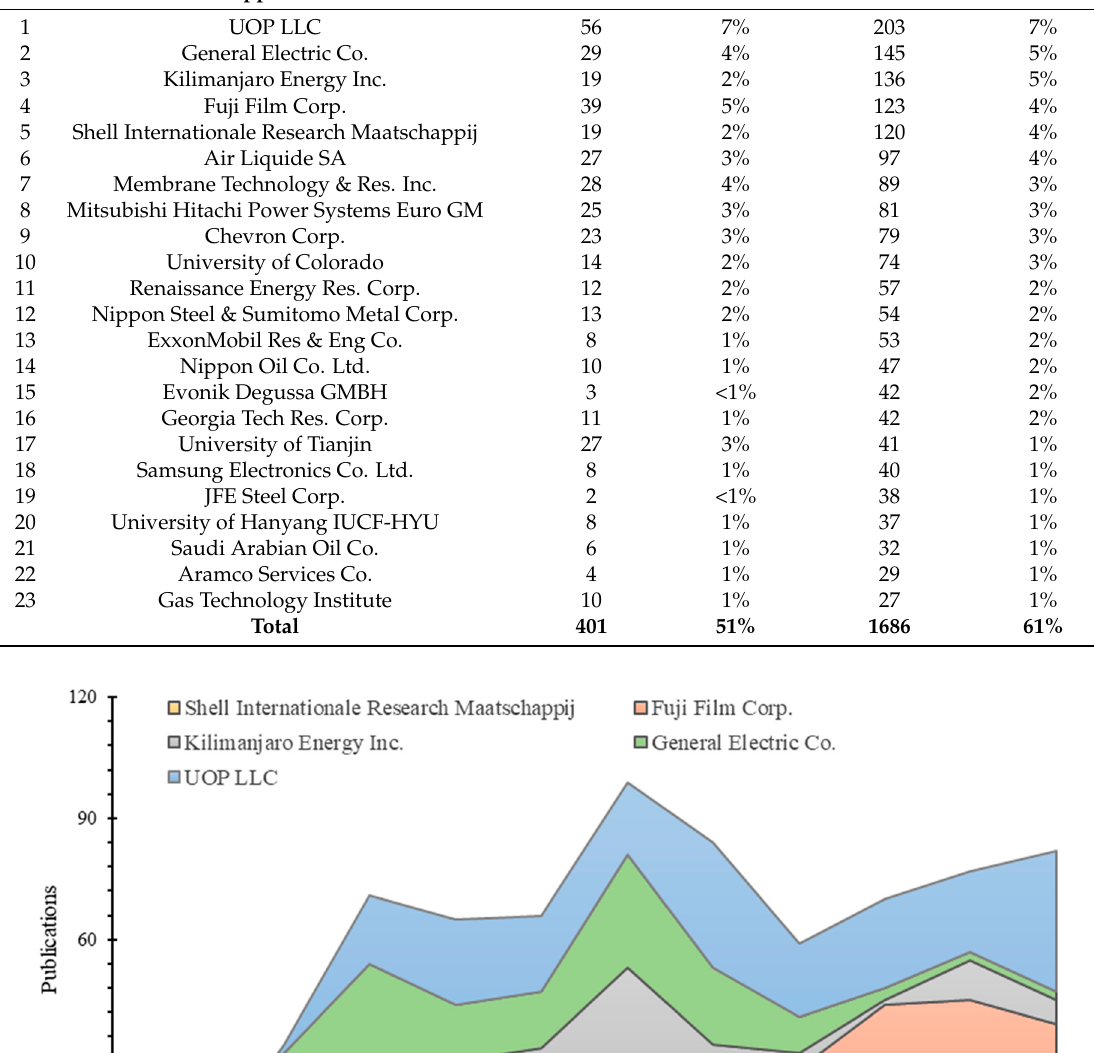
Table 2. Number of published patent families and individual patents according to the main assignees (Y02C 10/10).